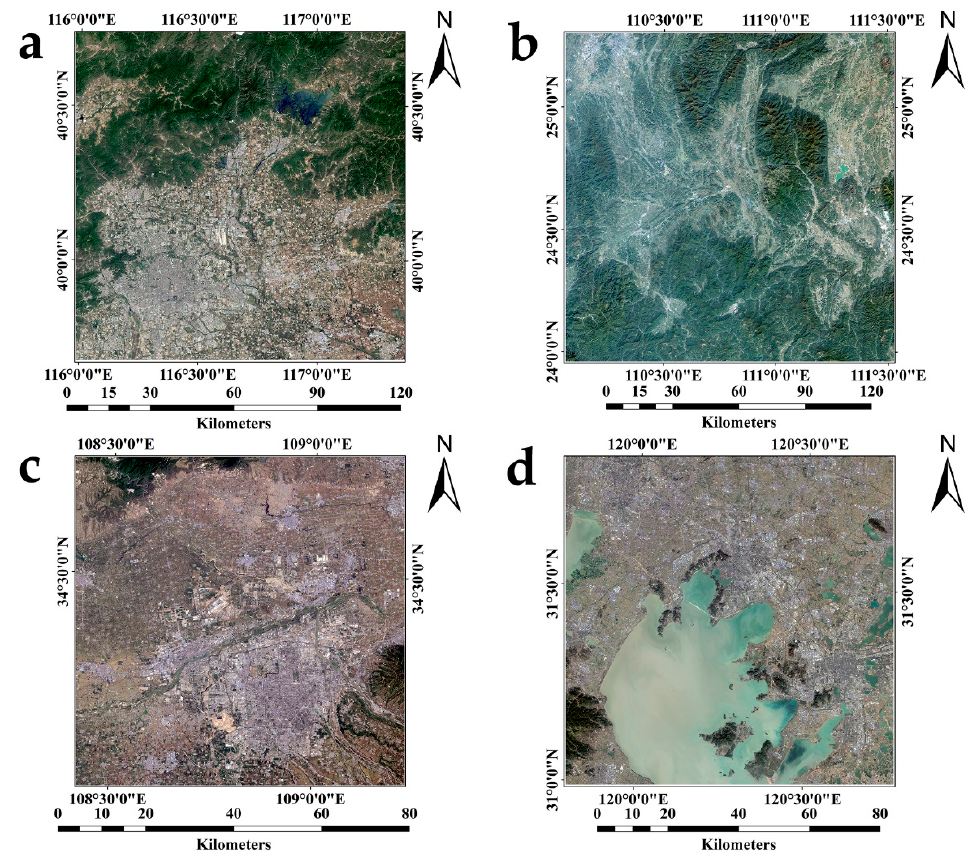
Figure 1. Landsat 8 OLI true color images at 30 m spatial resolution for the study sites: ( a ) site 1, Beijing; ( b ) site 2, Guilin; ( c ) site 3, Xi’an–Xian Yang; ( d ) site 4, Taihu River Basin.